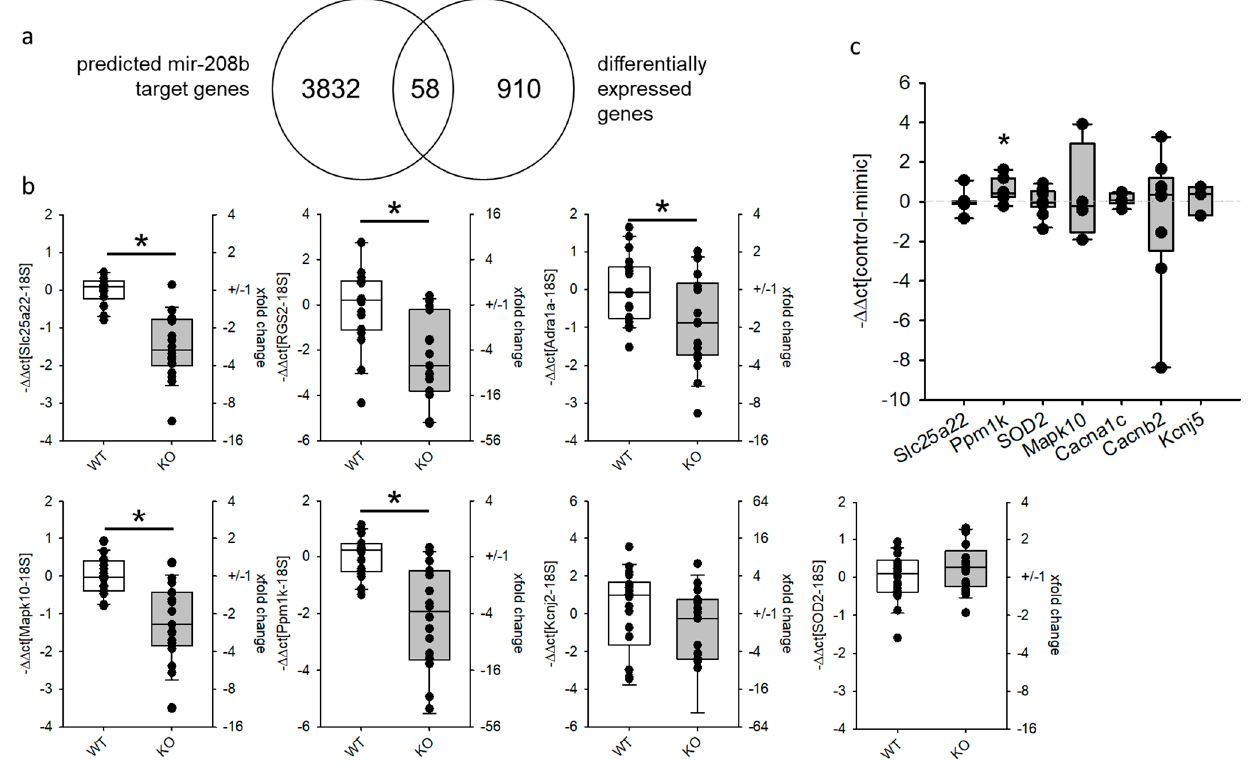
Figure 2. Differentially expressed target genes of miR-208b in the hearts of mice with severe heart hypertrophy. ( a ) Comparison of predicted miR-208b target genes (3 ′ -UTR, miR-walk 2.0) with downregulated genes identified by next-generation whole RNA sequencing (whole-heart WT versus KO, N = 6 animals/group) that revealed 58 common genes. ( b ) Real-time qRT-PCR for selected genes in additional whole-heart samples of mice with severe heart hypertrophy (N = 15–19 animals/group, * p ≤ 0.05 vs. WT). ( c ) Real-time qRT-PCR for selected miR-208b target genes in HL-1 cells transfected either with miR-208b mimics or mimic control (N = 3–7 samples/group, * p ≤ 0.05 vs. mimic control).